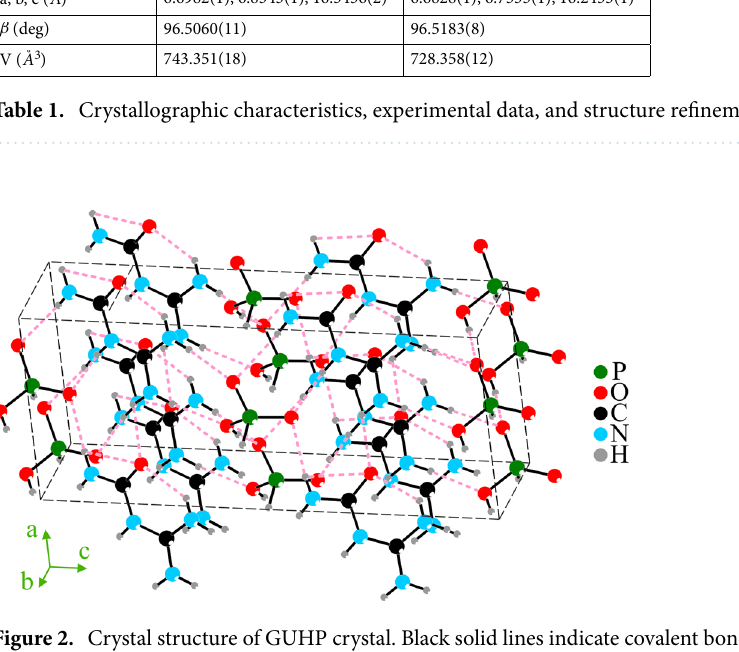
Figure 2. Crystal structure of GUHP crystal. Black solid lines indicate covalent bonds. Pink dashed lines indicate hydrogen bonds. In the diagram, two segregate groups can be distinguished: the organic guanylurea group (accumulations of nitrogen, carbon and oxygen atoms) and the inorganic phosphate group (phosphorus and oxygen